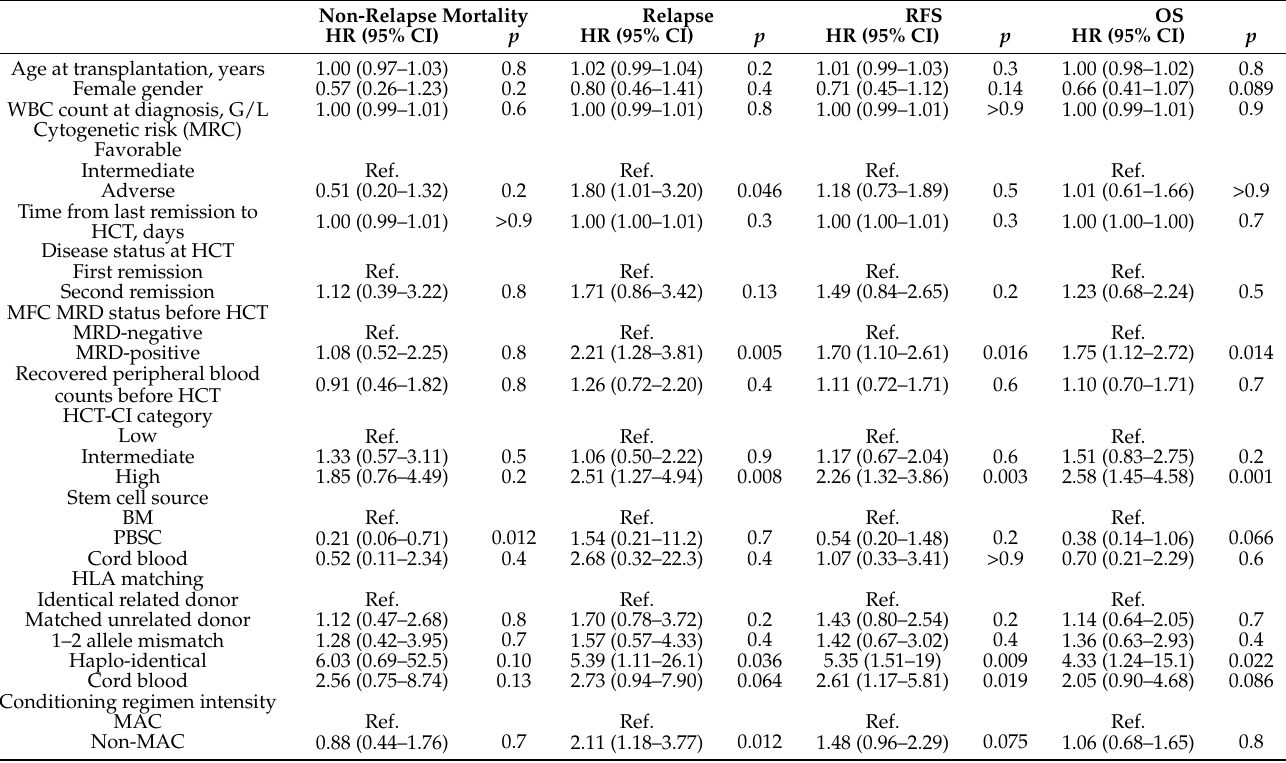
Table 4. Univariable regression models of patients with AHD ( n =